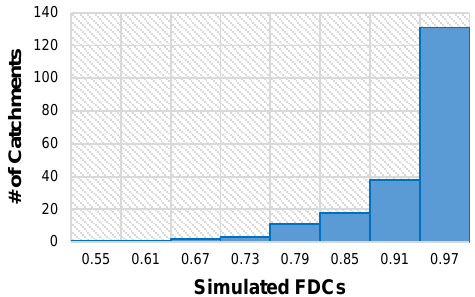
Figure 8. NSE of simulated daily FDCs based on monthly FDC.